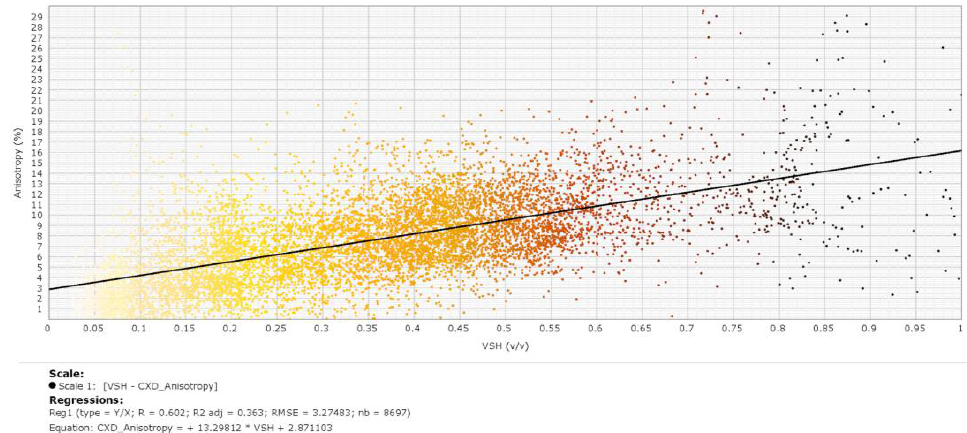
Figure 7. Cross-plot showing VSH in v/v units ( x -axis) and dipole acoustic anisotropy in percent ( y -axis). The cross-plot is colored by VSH values, with lower values in the lighter colors (carbonates) and higher values in the darker colors (shales). The sample size of the dataset (nb) is 8697 datapoints. The correlation (R) between the predictor variable VSH and the response variable anisotropy is 0.602. The low correlation suggests additional factors contribute to the measured